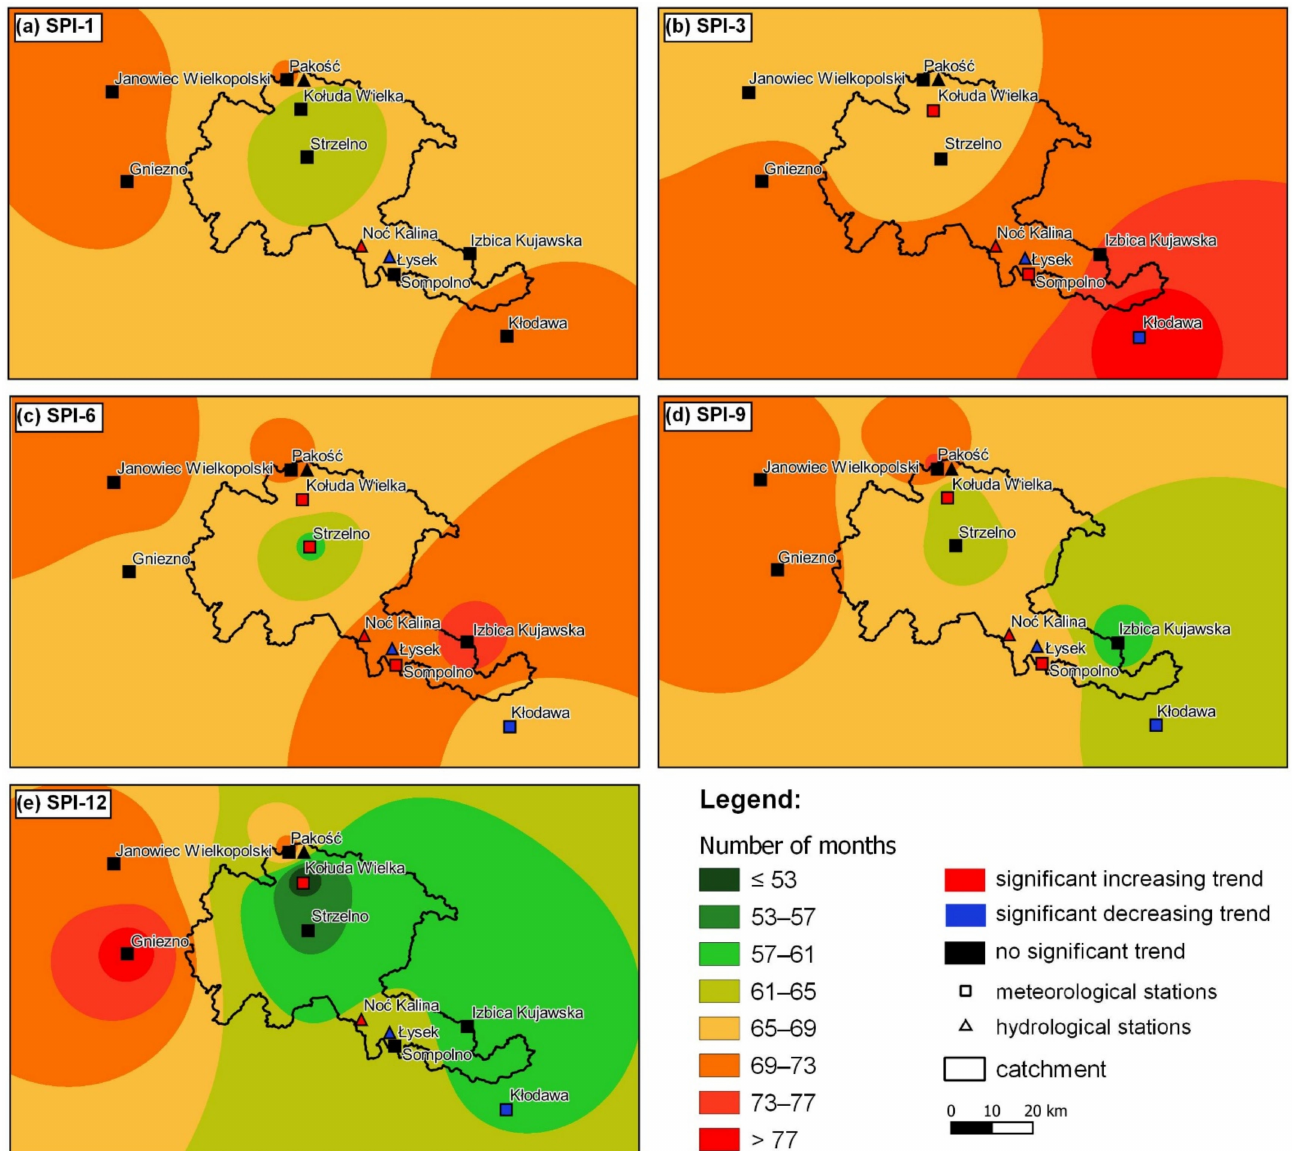
Figure 3. Spatial distribution of the number of months with SPI ≤ − 1.0 in the period of 1981–2016. Source: ( a – e ) own elaboration made with [52], Table 4, Tables 6 and 7. Location of the stations based on [55,56] and Table 1. Meteorological station Izbica Kujawska is out of catchment area according to coordinates from Table 1. Location of the hydrological station Pako´s´c is determined by cartographic issues. Maps elaborated in the coordinate system: WGS 84/UTM zone